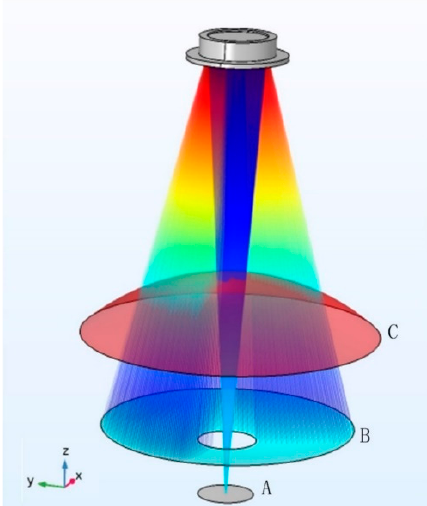
Figure 13. Optical path diagram of the secondary mirror. A: The ideal image plane; B: The outgoing surface of light; C: The Gaussian reference sphere.